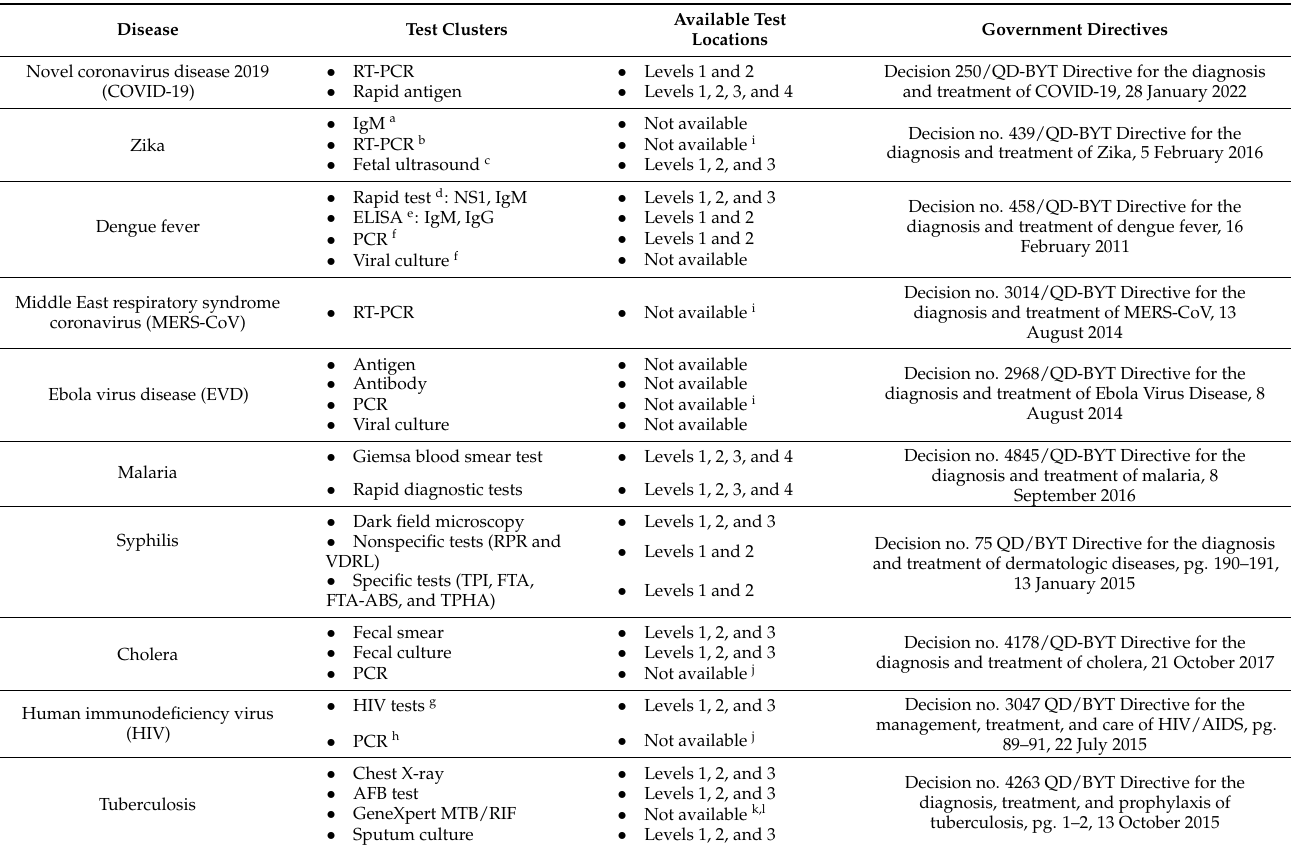
Table 9. Government directives, test clusters, and available testing locations for patients with highly infectious